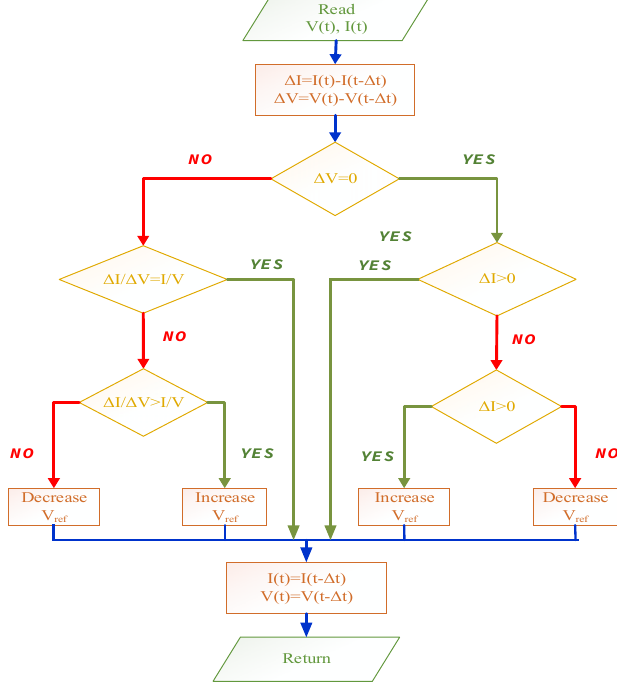
Figure 3. Flowchart of Perturb and Observe (P&O) based MPPT control strategy.